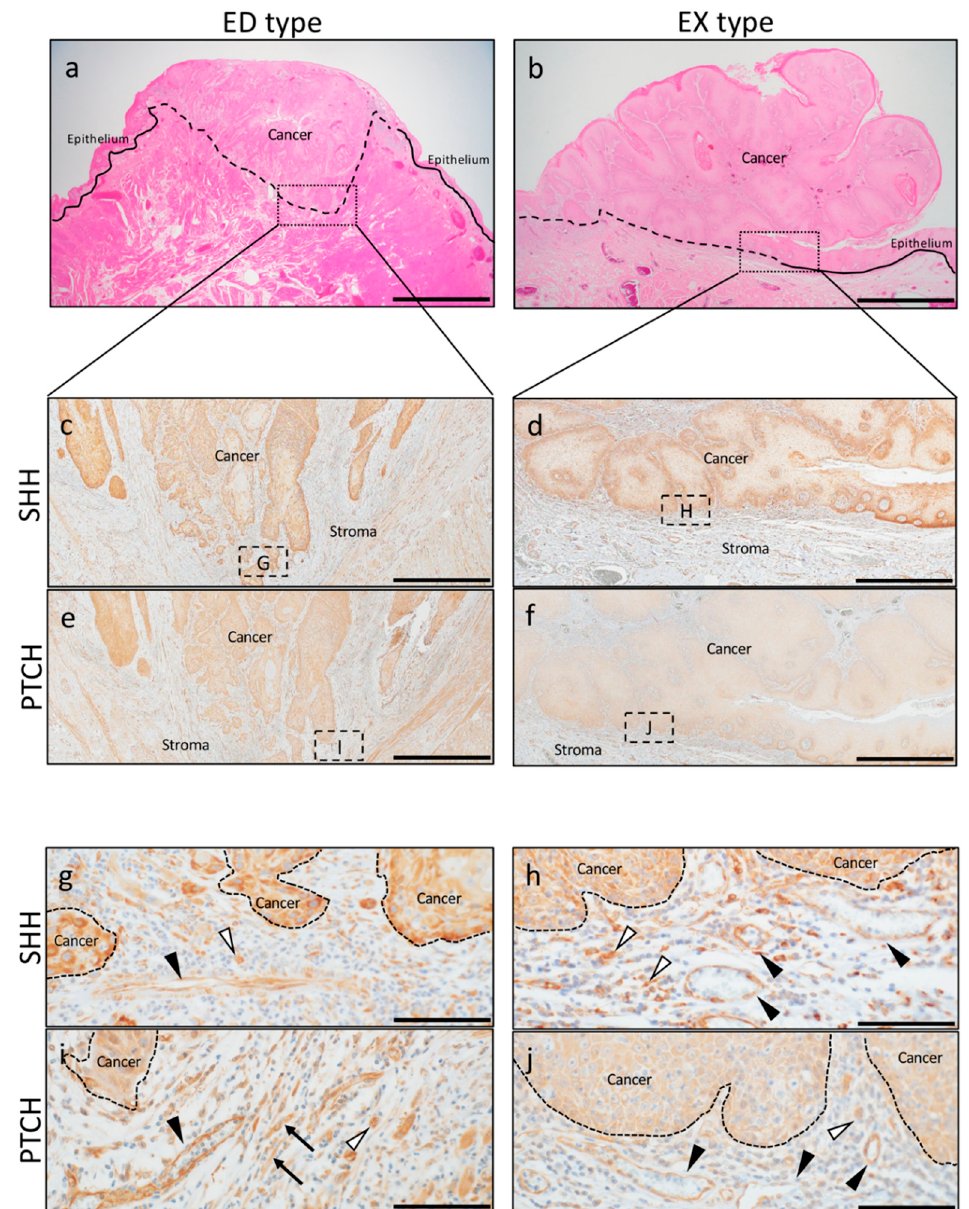
Figure 1. Representative pictures of immunohistochemical staining of sonic hedgehog (SHH) and Patched-1 (PTCH) in endophytic (ED)-type and exophytic (EX)-type oral squamous cell carcinoma (OSCC). ( a , b ) H&E staining of ED type and EX type. Scale bars: 2 mm. ( c , d ) Low-power magnification of SHH immunohistochemistry (IHC) staining. Scar bar: 1 mm. ( e , f ) Low-power magnification of PTCH IHC staining. Scale bar: 1 mm. ( g , h ) High-power magnification of SHH IHC staining. The expression of SHH in the cancer stroma was expressed in blood vessels (block arrowheads) and round cells (white arrowheads). Scale bar: 100 µ m. ( i , j ) High-power magnification of PTCH IHC staining. The expression of PTCH in the cancer stroma was stronger in EX type than in ED type and was positive for blood vessels (block arrowheads), round cells (white arrowheads), and spindle-shaped cells (arrows). Scale bar: 100 µ